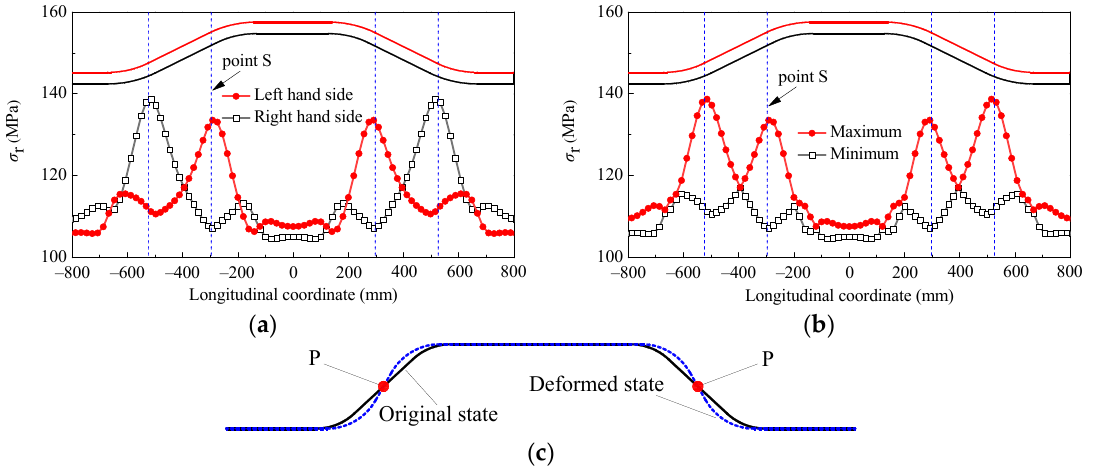
Figure 12. Deformation mechanisms: ( a ) stress distribution; ( b ) stress envelope; and ( c ) schematic of CSW deformations.